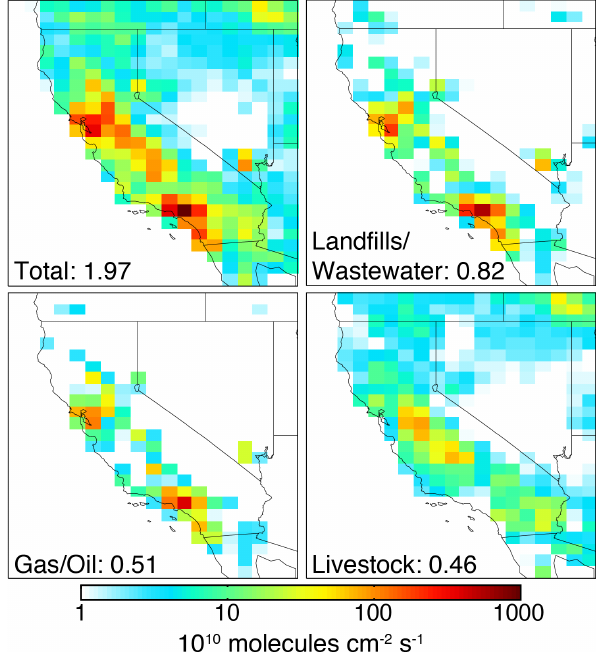
Figure 1. EDGAR v4.2 methane emissions for 2008 used as a pri- ori for our inversion. Panels show total emissions and contributions from the three major source types. California totals inTga − 1 are inset. Values are averaged over the 1/2 ◦ × 2/3 ◦ GEOS-Chem